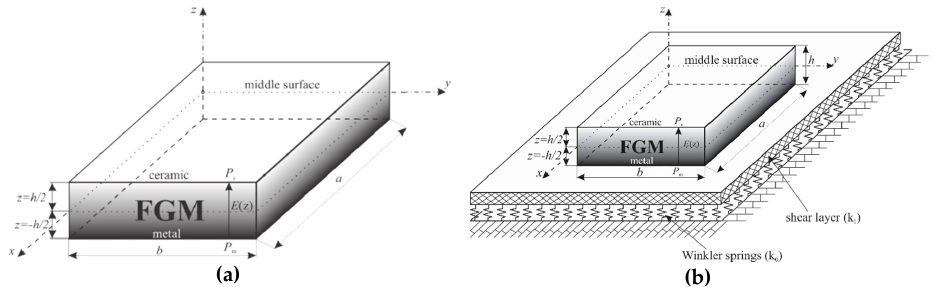
Figure 3. Geometry of the plate: ( a ) FGM plate; ( b ) FGM plate on elastic foundation.